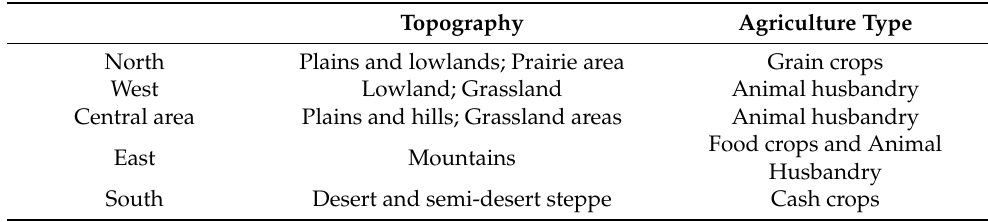
Table 1. A topography and agricultural layout of Kazakhstan [15].